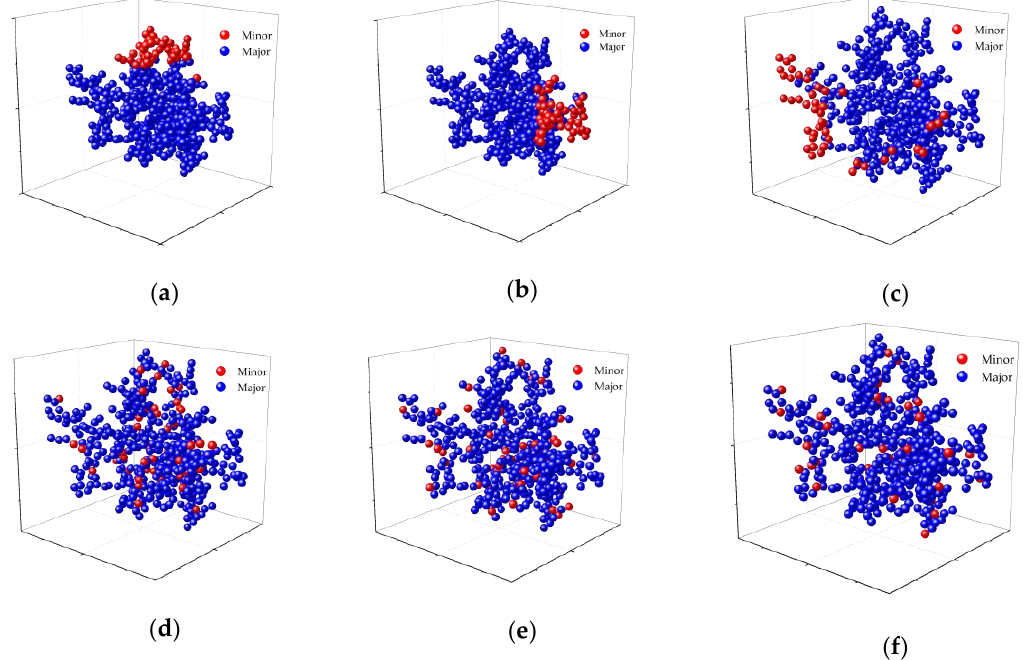
Figure 2. Different position patterns of the minor component particles: particles gathered in minor spheres (red) in the upper ( a ), in the right ( b ), and in the front( c ) and randomly positioned particles in ( d ) – ( f ).